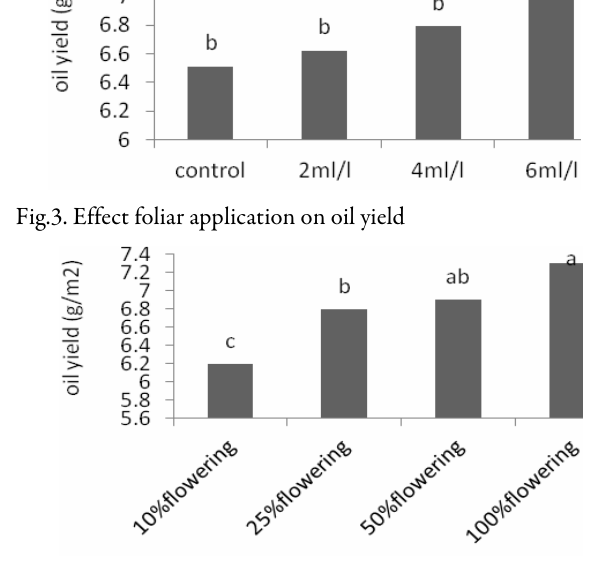
Fig.4. Effect harvest time on oil yield